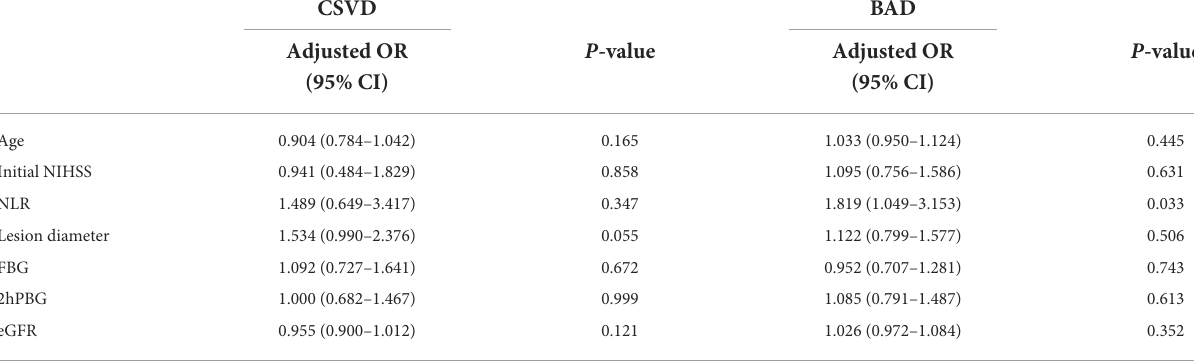
TABLE 4 Logistic regression analysis of factors associated with END in the BAD and CSVD